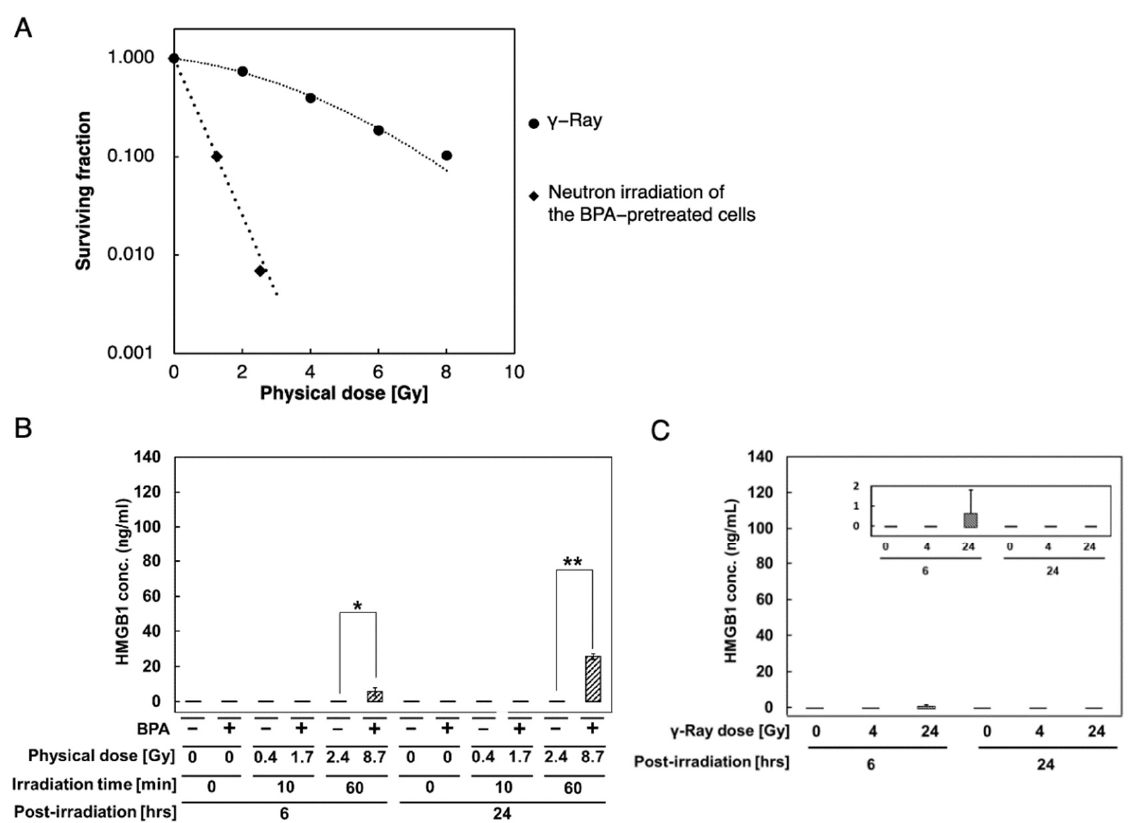
Figure 3. Increased extracellular HMGB1 levels in the culture supernatant of A375 cells after neutron irradiation with BPA. ( A ) Cell survival curves of A375 cells. A375 cells treated with γ -irradiation (closed circle) and BPA-pretreated cells irradiated with neutrons (closed diamond) are shown. The surviving fractions were assessed based on colony formation assay. ( B , C ) Analysis of HMGB1 levels in the culture supernatant of A375 cells after neutron irradiation with BPA at 25 ppm [ 10 B] ( B ) and γ -irradiation ( C ) using ELISA (( B ) SHINOTEST, ( C ) Abnova). HMGB1 concentration ranged from 0–2 ng/mL. The background value of the medium was subtracted from each data point. The experiments were performed in triplicate. Data are presented as mean ± S.E. *, p < 0.05 and **, p <